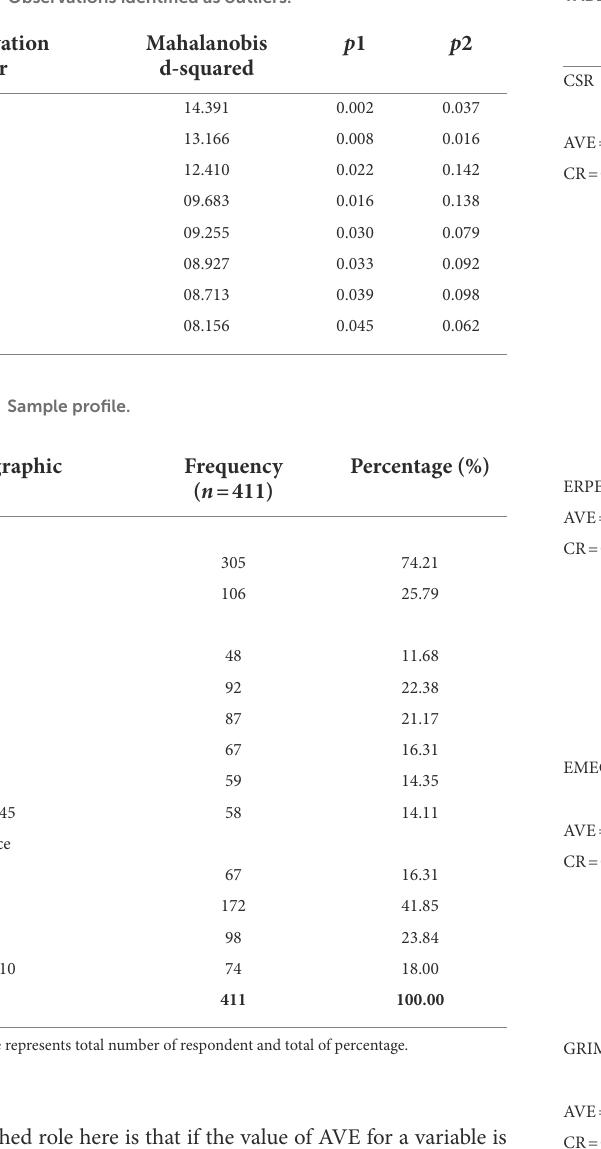
TABLE 4 Validity and reliability. TABLE 2 Observations identified as outliers.